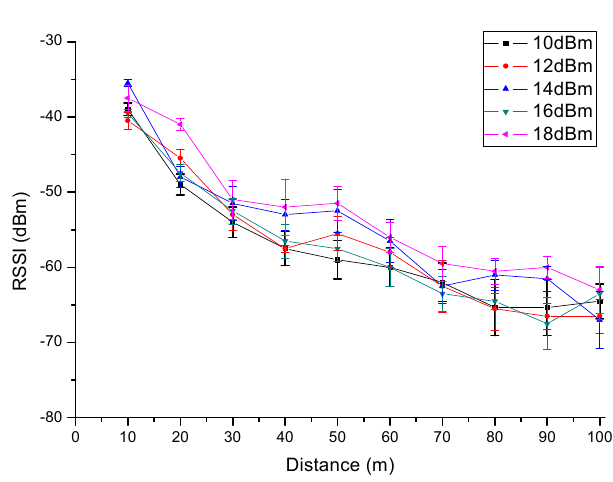
Table 1. 11 frequency channels of the RF module.